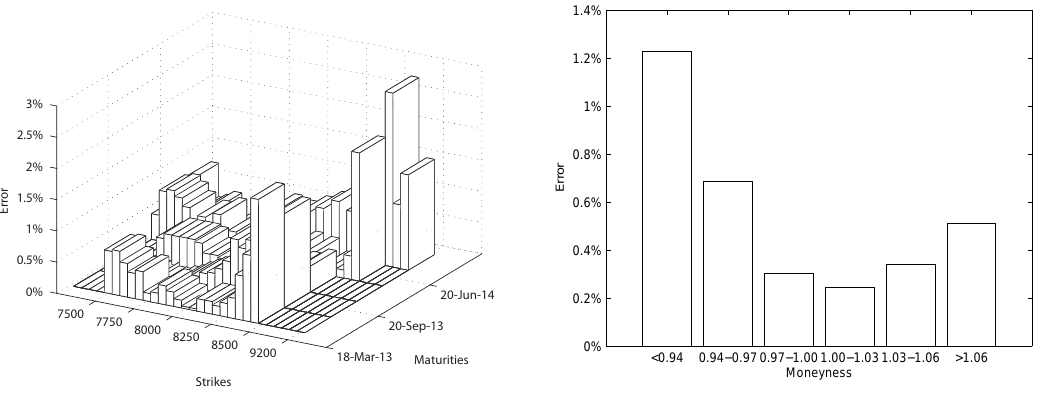
Fig. 5. Results for Excel’s solver. The left picture portrays the absolute relative errors. The right picture shows the average absolute relative errors in terms of moneyness. The initial point was provided by